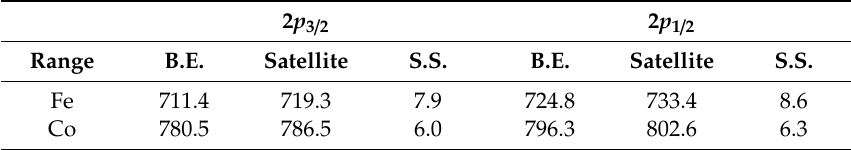
Figure 7. XPS spectra of the ( a ) Fe 2p and ( b ) Co 2p core-level regions of CFO nanodots, in which the black open circles indicate the experimental data, the red solid lines are the fitted envelope. The different fitted components are also plotted. A and B sites represent the tetrahedral and octahedral sites in the inverse spinel crystal structure, respectively. Table 5. Binding energy (B.E.), satellite peak position and the satellite splitting (S.S.) energy difference of the XPS spectra. All numbers are in unit eV.